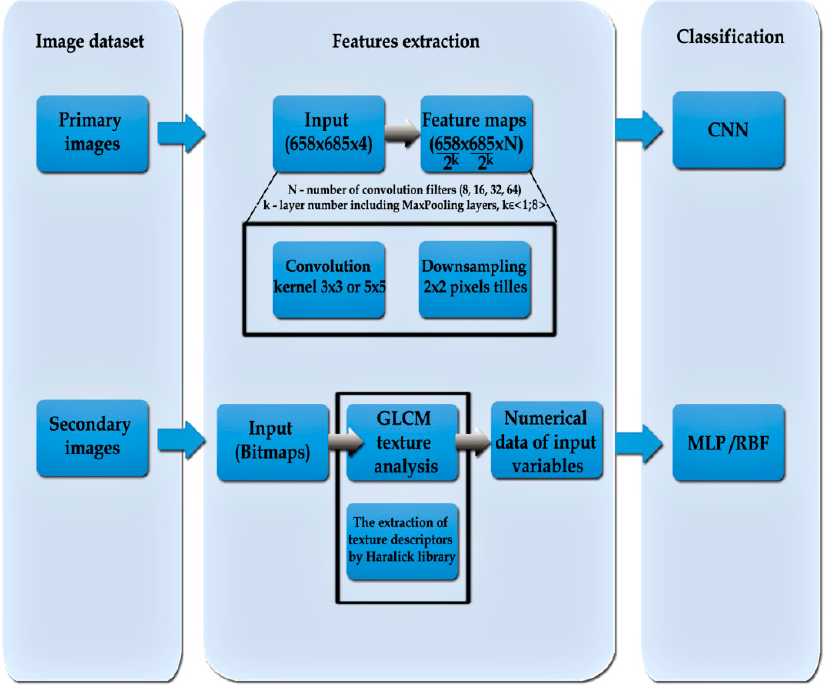
Figure 4. Algorithm schema of processing an image in the process of creating neural networks including deep and machine learning. In the case of CNN, the network model responded both to the extraction of features and to classification.